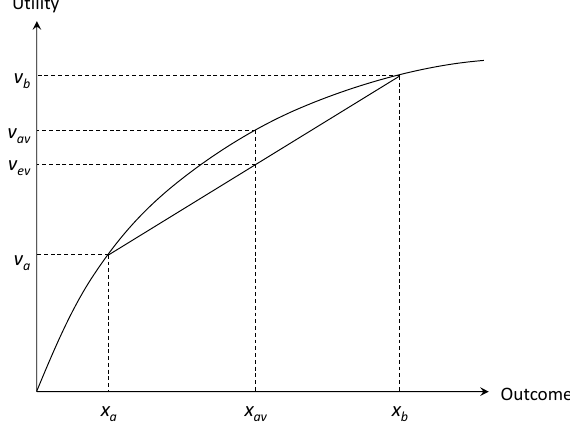
Figure 2. The utility function of a risk-averse consumer.